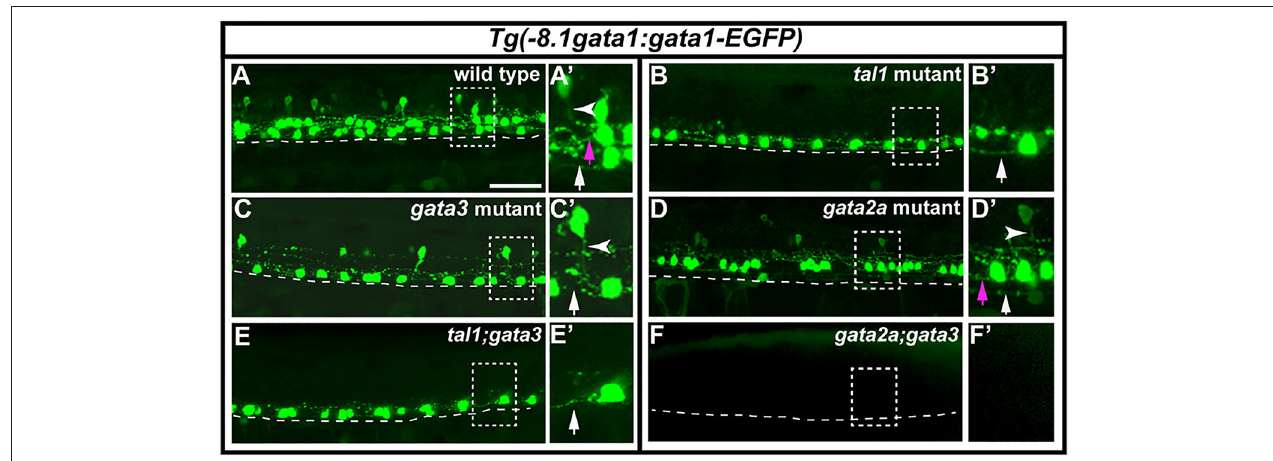
FIGURE 9 | Expression of Tg(-8.1gata1:gata1-EGFP) in single and double mutants. Lateral views of 30h Tg(-8.1gata1:gata1-EGFP) WT sibling (A) and single and double mutants as indicated (B–F) . Dorsal, top; anterior, left. Dashed rectangle regions in main panels (A–F) are shown in magnified view in adjacent (A ′ –F ′ ) panels. Dashed lines indicate ventral limit of spinal cord. White arrows indicate KA ′′ axons, magenta arrows indicate KA ′ axons and white arrowheads mark V2b axons. KA ′′ and KA ′ axons are ipsilateral and ascending whereas V2b axons are ipsilateral descending. KA ′′ neurons appear to form normally and extend WT-like axonal projections in tal1;gata3 double mutants (E,E ′ ) . In contrast, even though GFP-expressing V2b cells are present in both gata3 (C,C ′ ) and gata2a (D,D ′ ) single mutants there are no GFP-expressing V2b cells in gata2a;gata3 double mutants (F,F ′ ) . Scale bar = 50